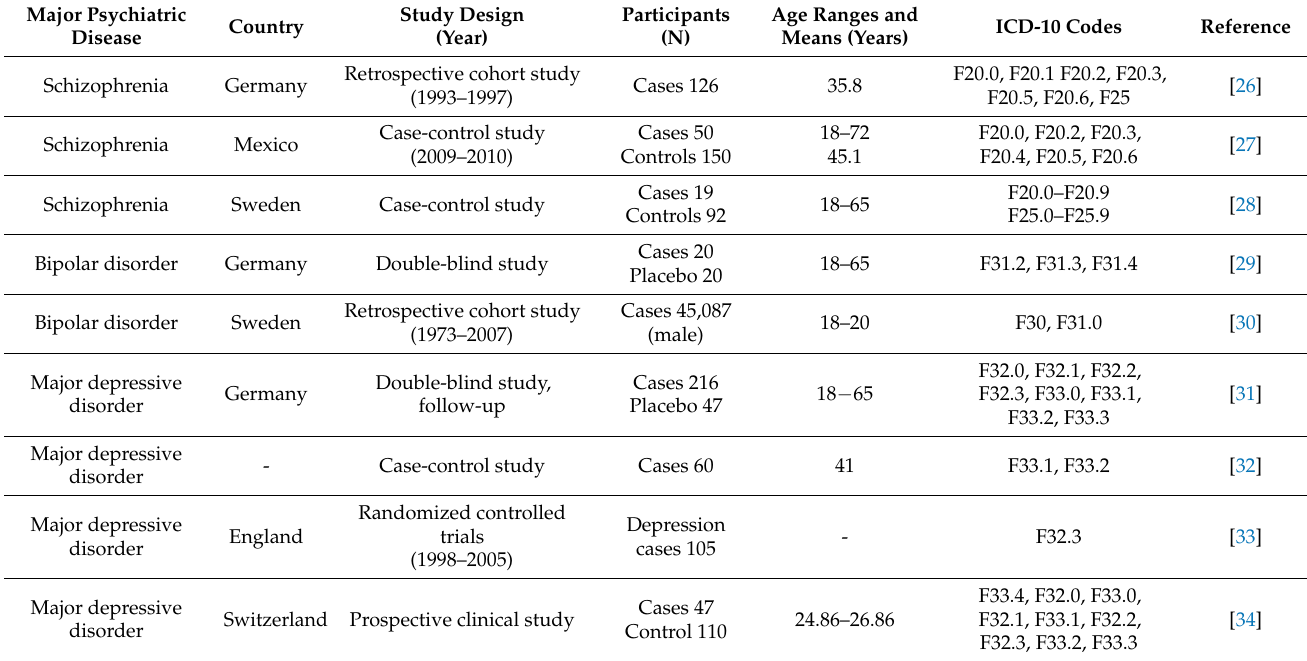
Table 1. Literature review of major psychiatric diseases using ICD-10 codes.